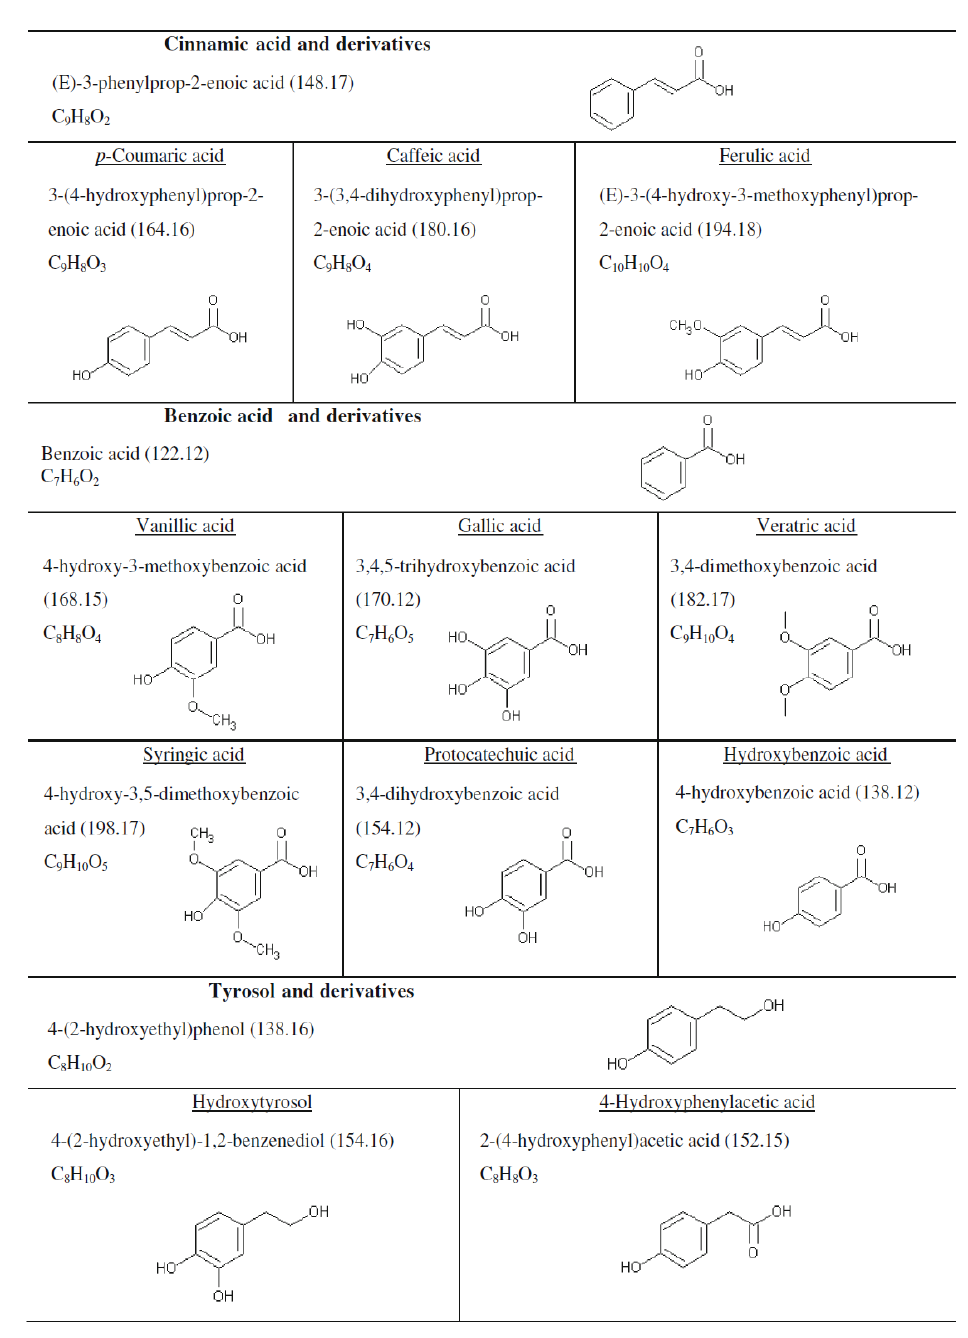
Figure 10. Most abundant phenolic compounds, chemical structure, and IUPAC names detected in OMW. Reprinted with permission from Reference [182]. Copyright 2011. Springer.